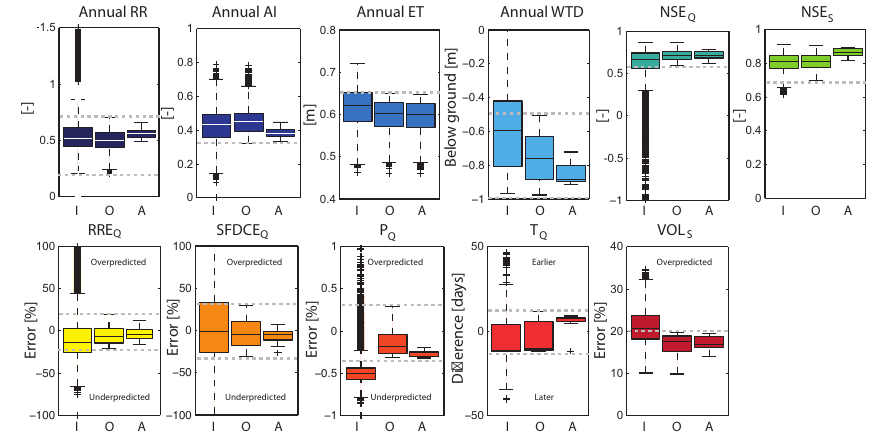
Figure 5. The distribution of model-predicted behavior across initial distributions of all behavior (I), distribution of values that meet a given behavioral constraint (O), and distribution of values that meet all 11 constraints (A). Constraints are indicated by grey dashed lines. Colors correspond to different metrics outlined in Fig. 3.